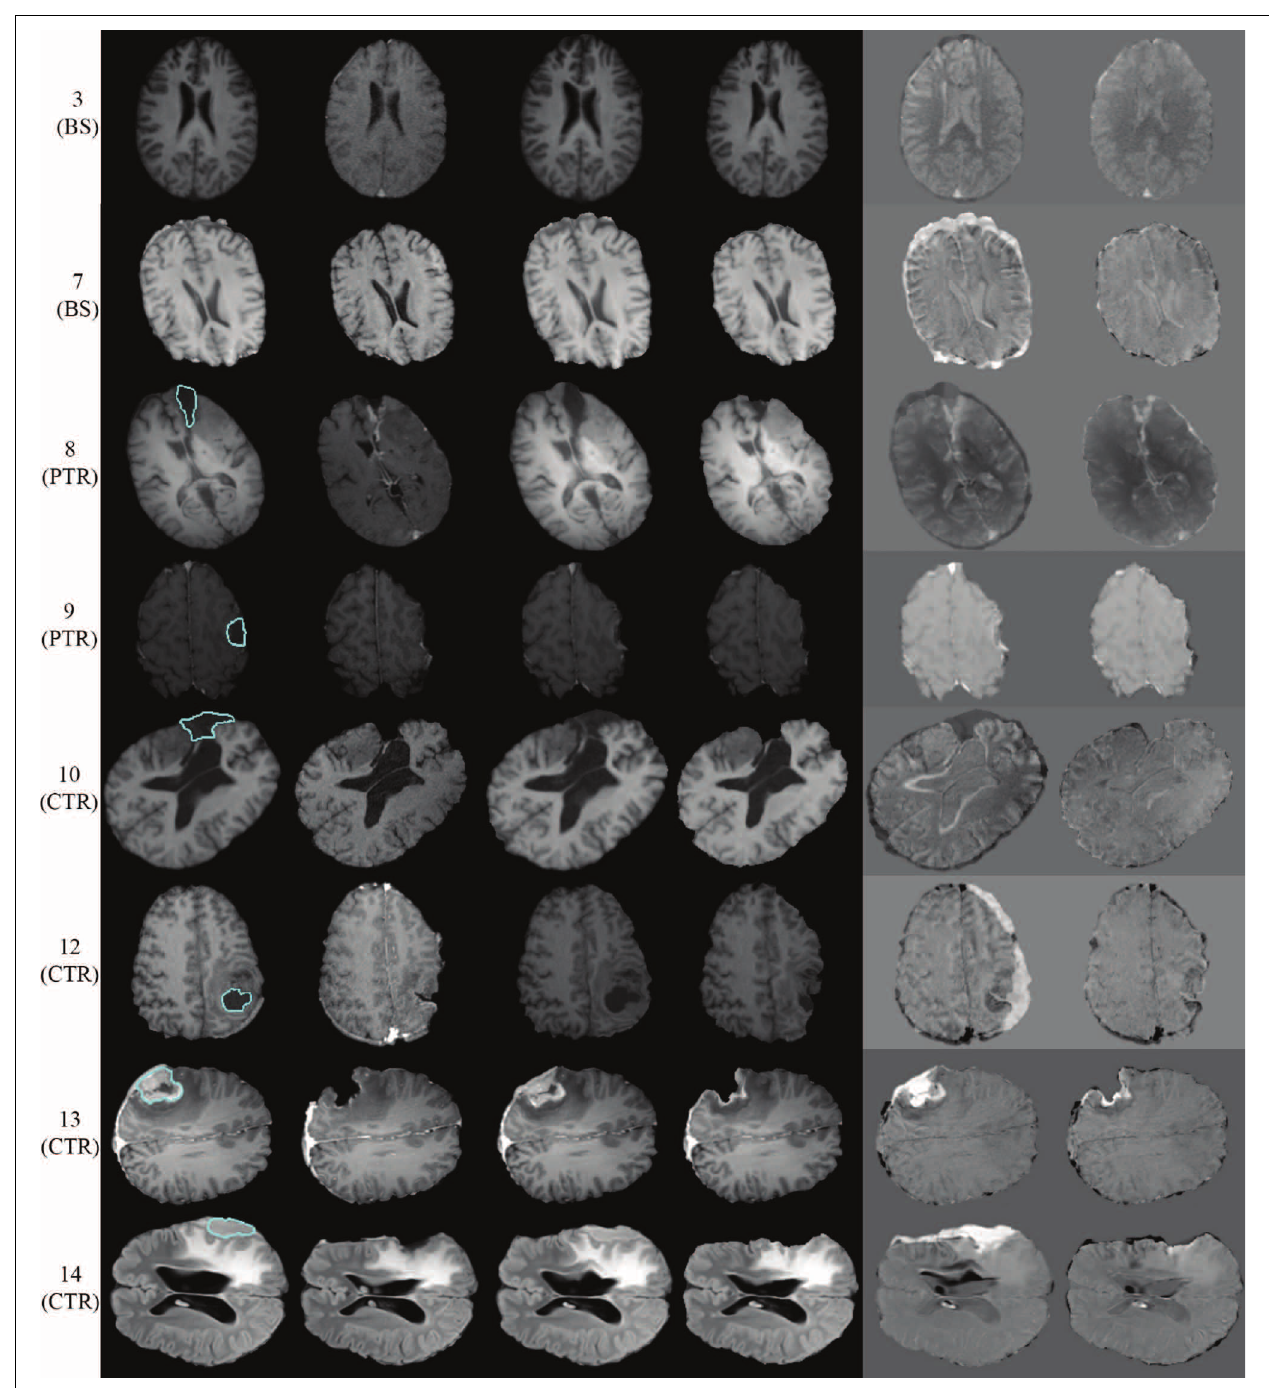
FIGURE 5 | Qualitative evaluation results for 8 of the 14 case studies. Each row represents a single case. The left margin indicates the number and the type of each case. From left to right column: pre-op MRI, intra-op MRI, warped pre-op MRI (PBNRR), warped pre-op MRI (APBNRR), warped pre-op